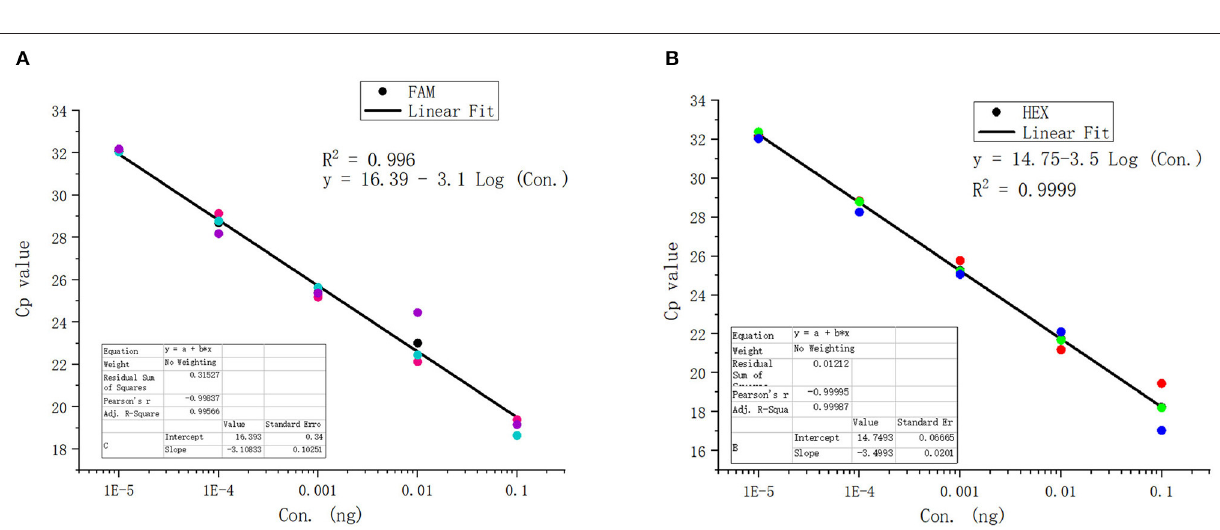
and simultaneously detect EP. In addition, Montes Cortés